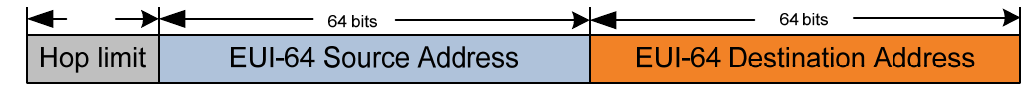
Figure 6. Addressing format to communicate among SMAGs under same border router.